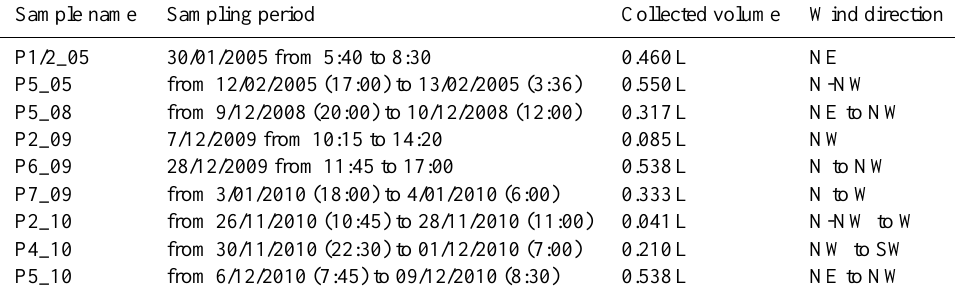
Table 2b. Sampling conditions for the possible contaminated rain